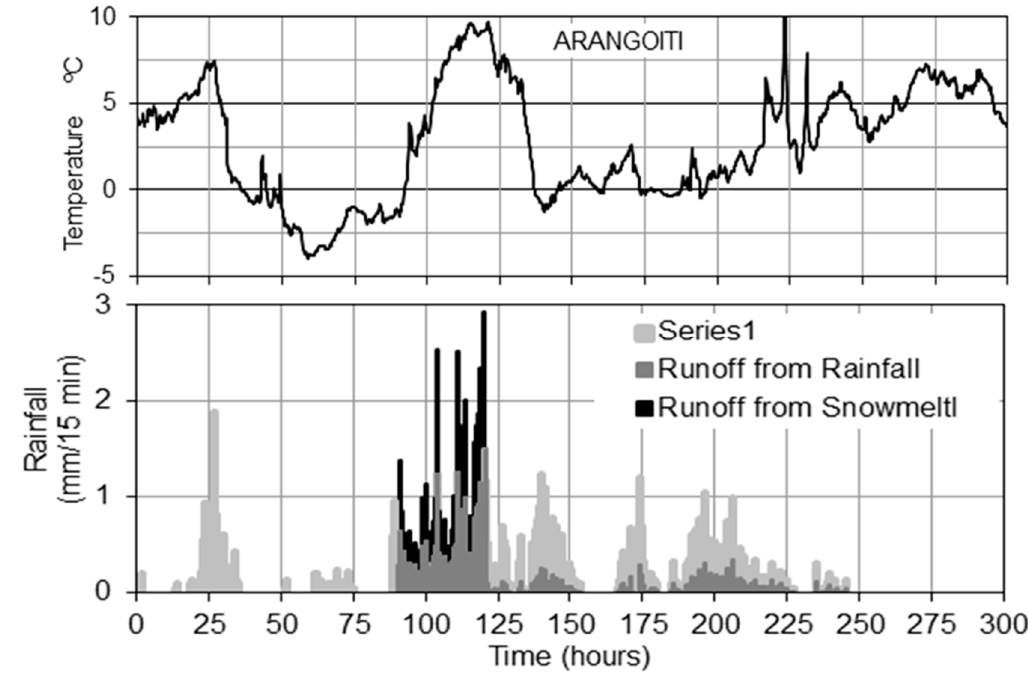
Figure 7. Temperature graph at the Arangoiti station during the episode of January 2009 and hyetographs of total and effective precipitation with snowmelt in the Esca river.